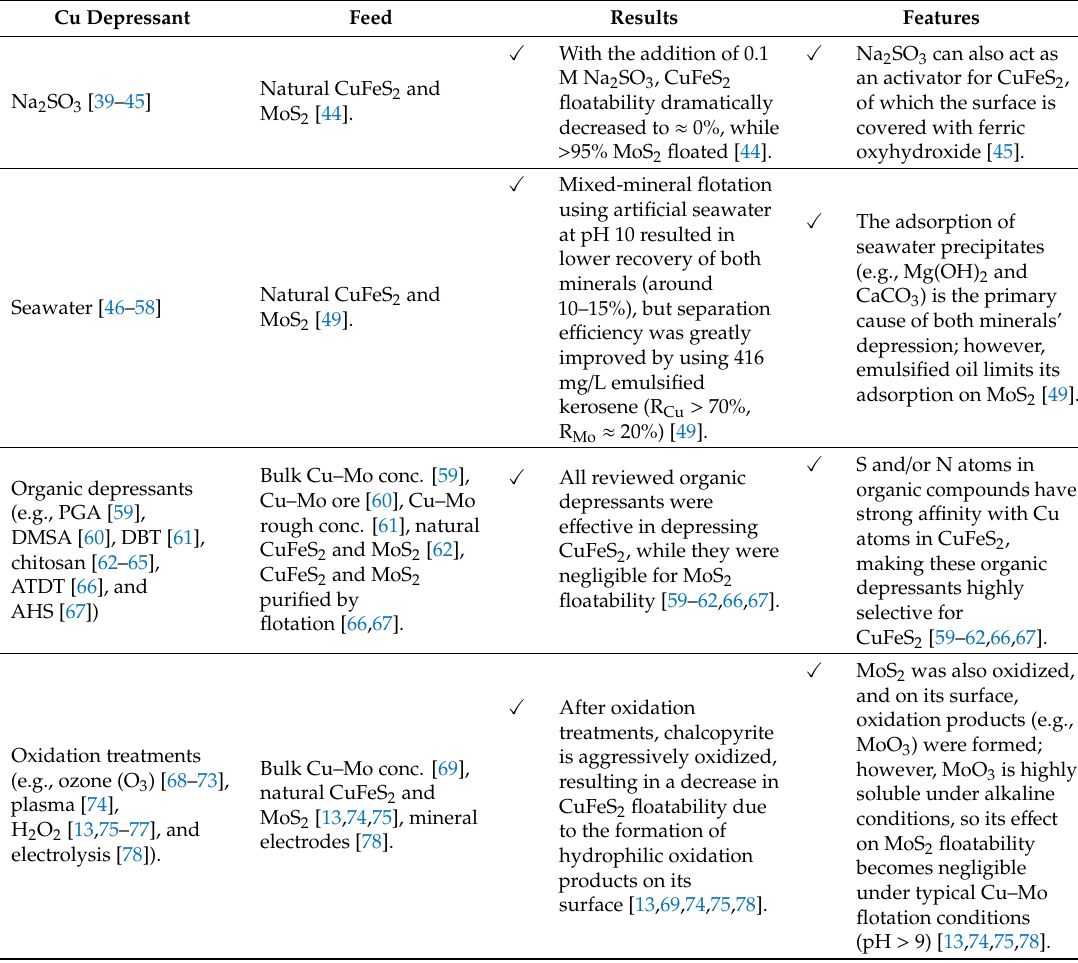
Table 3. Summary of chalcopyrite